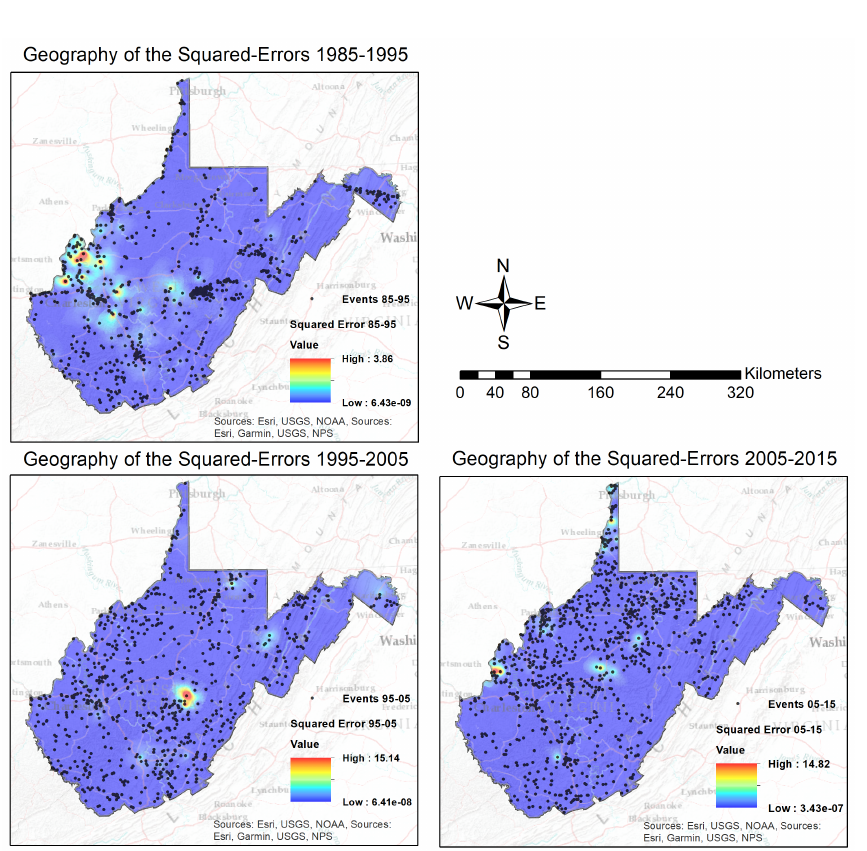
Figure 9. Geography of the